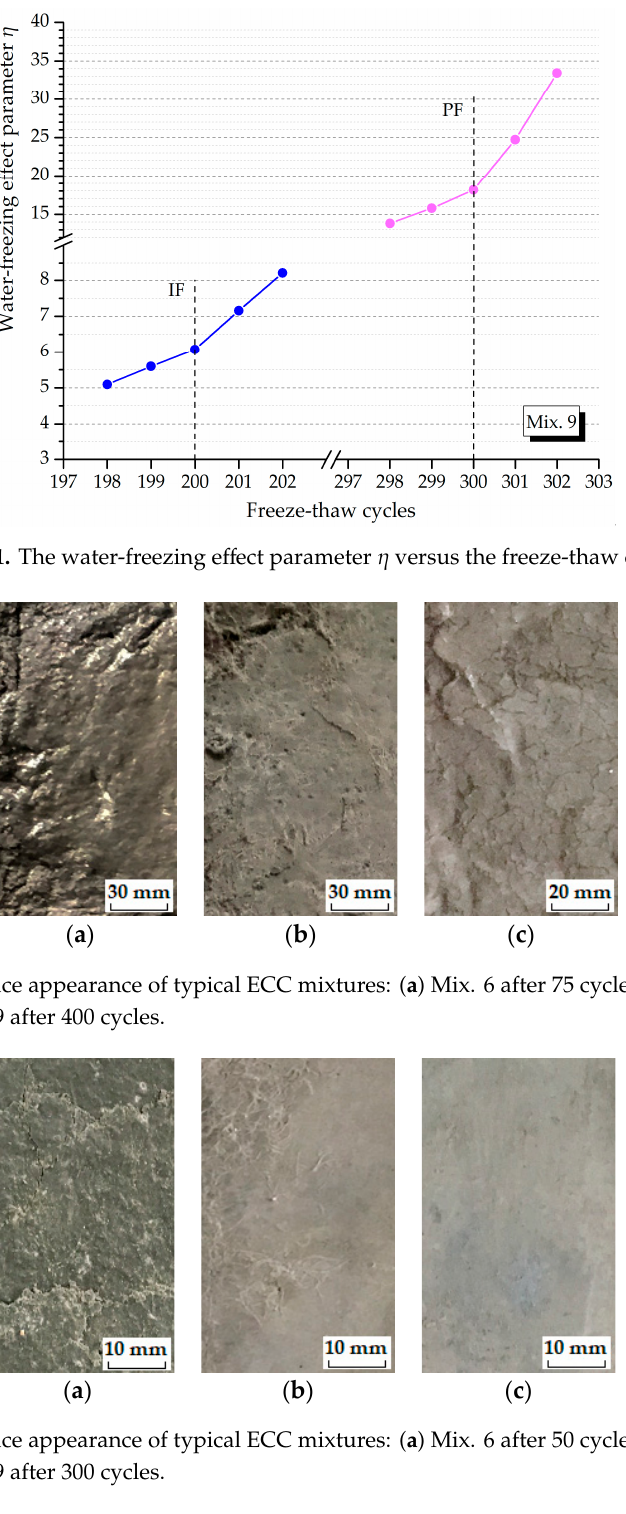
Figure 10. The strain variations of Mix. 9 with temperature profile under freeze-thaw cycles around different failure point: ( a ) IF; ( b ) PF; ( c ) UF.